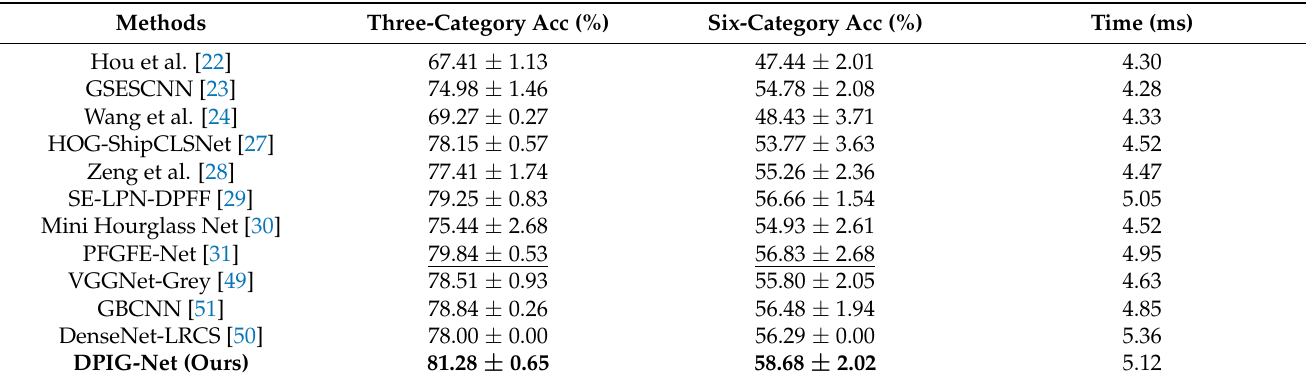
Table 4. Classification Performance of Different